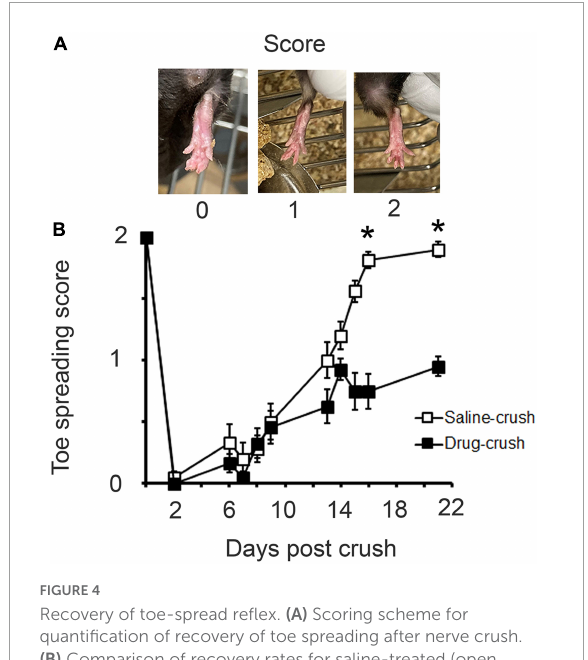
FIGURE4 Recovery of toe-spread reflex. (A) Scoring scheme for quantification of recovery of toe spreading after nerve crush. (B) Comparison of recovery rates for saline-treated (open squares) vs. AP5&CNQX-treated (filled squares) animals. Asterisks indicate that a significant difference is reached by day 16. Non-parametric Friedman test, p < 0.001, n = 10 animals for saline and drug-crush.